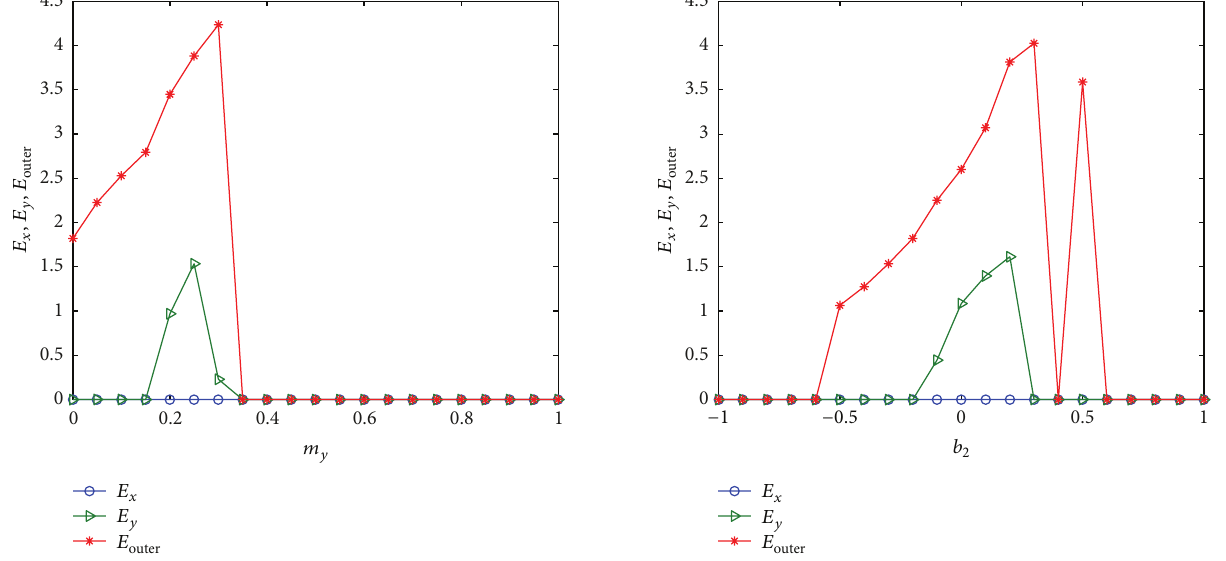
at 𝑡 = 400 regarding outer = 0.5 and 𝑁 = 10,𝑚 = 0.2 , and 2 𝑥